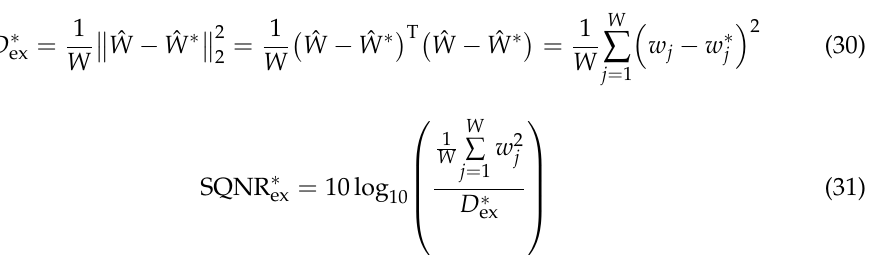
Algorithm 1 : Weights compression by means of post-training quantization using SPTQ / MSPTQ.